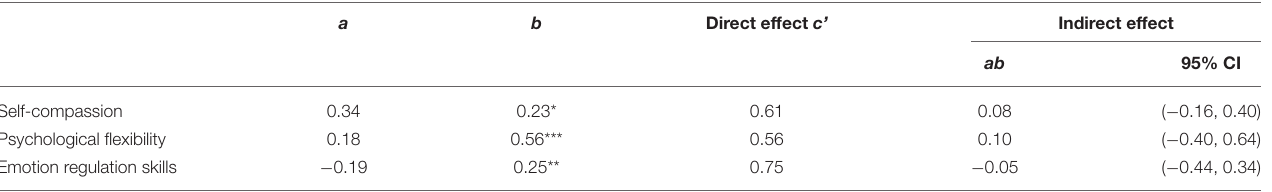
TABLE 5 | Multilevel coefficients and indirect effects for mediation of psychological processes on positive mental health in the control